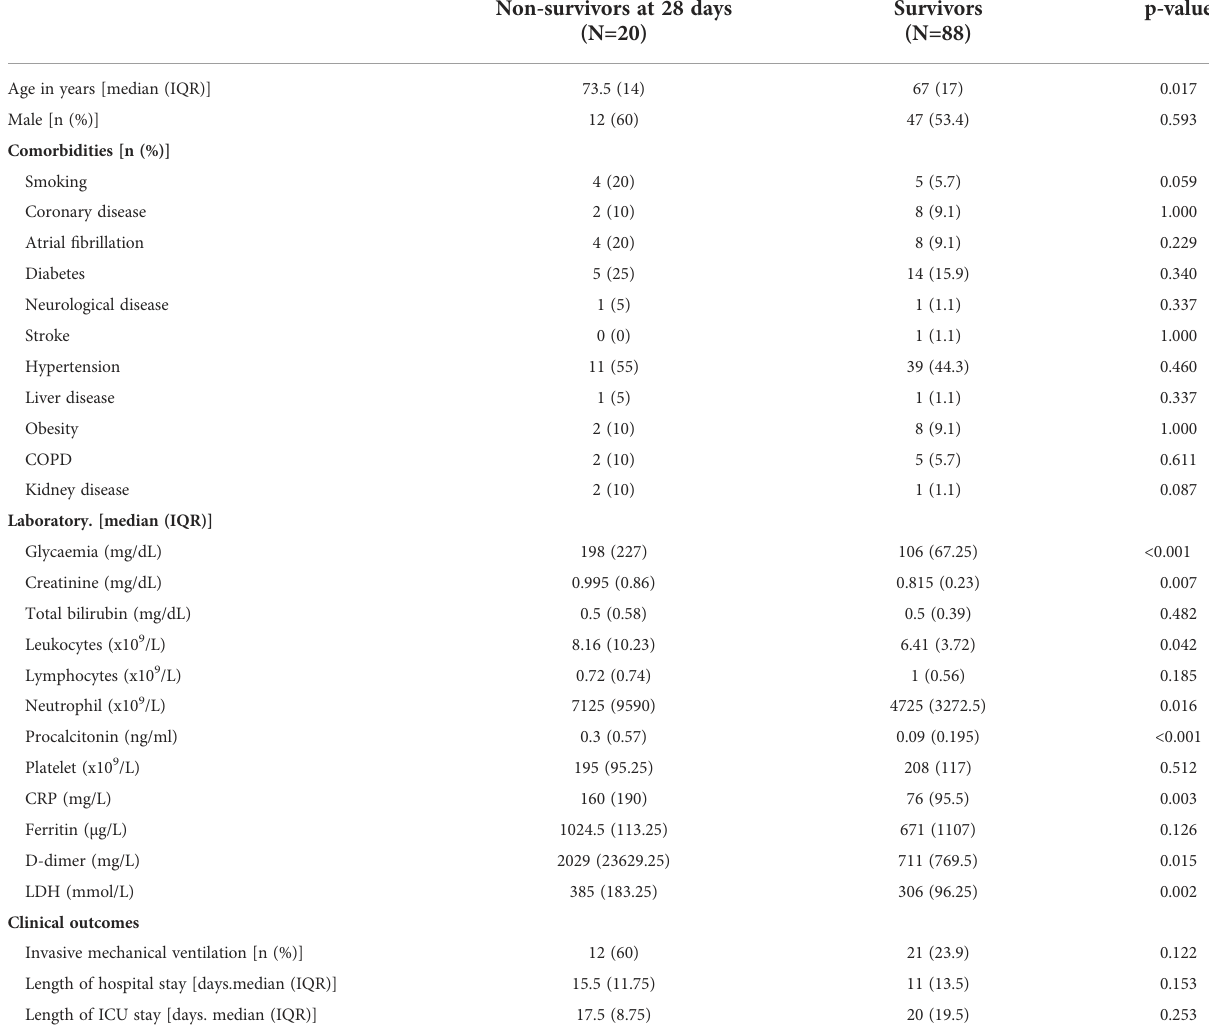
TABLE 1 Clinical characteristics of the patients. Data are represented as [median (IQR)] and as [%